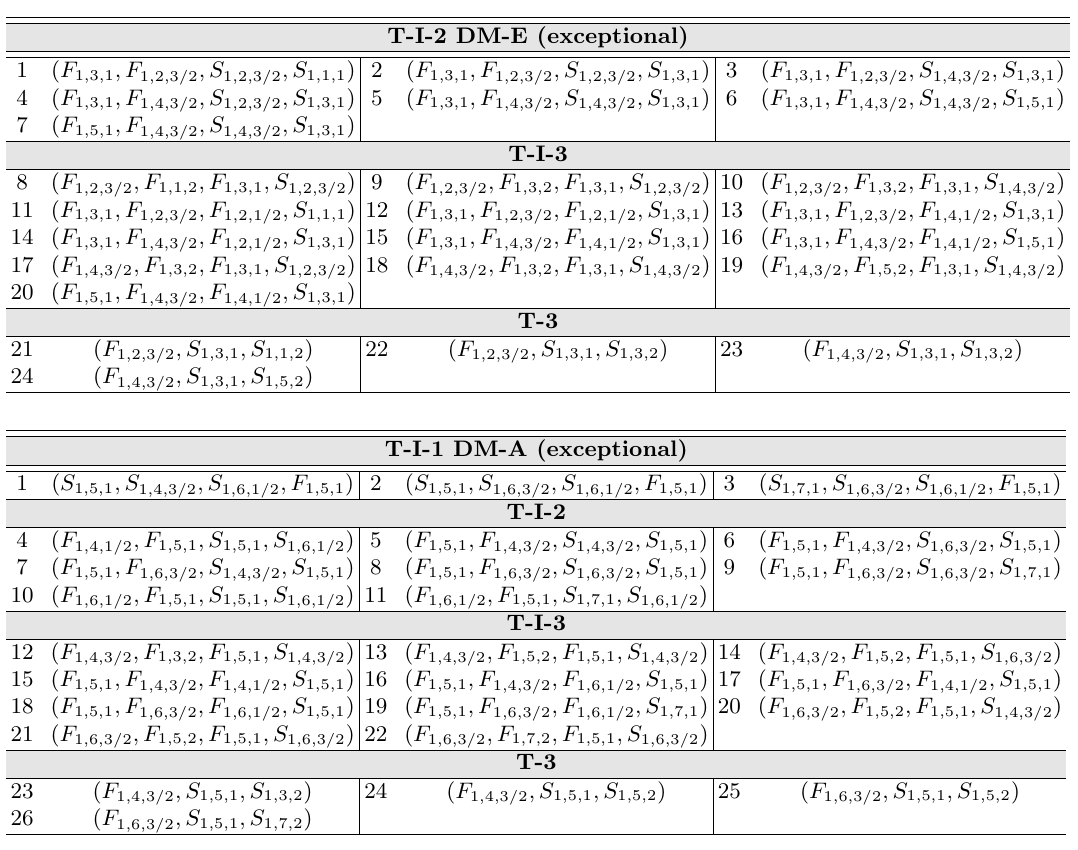
Table 10 . Exceptional DM candidates with Y = 1 . The table at the top corresponds to DM models with exits (DM-E) which need a stabilizing symmetry and the table at the bottom to accidental DM models